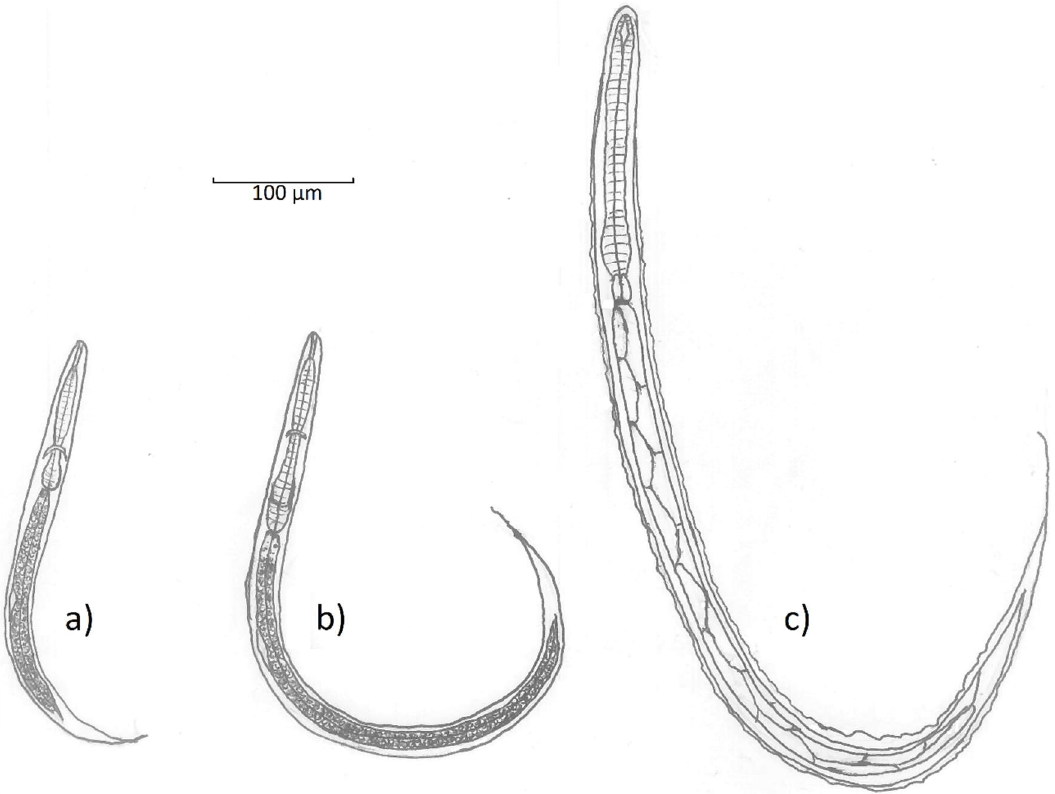
Figure 4. Line drawings showing the morphology of a ) rhabditiform (L1) larva; b ) rhabditiform (L2)